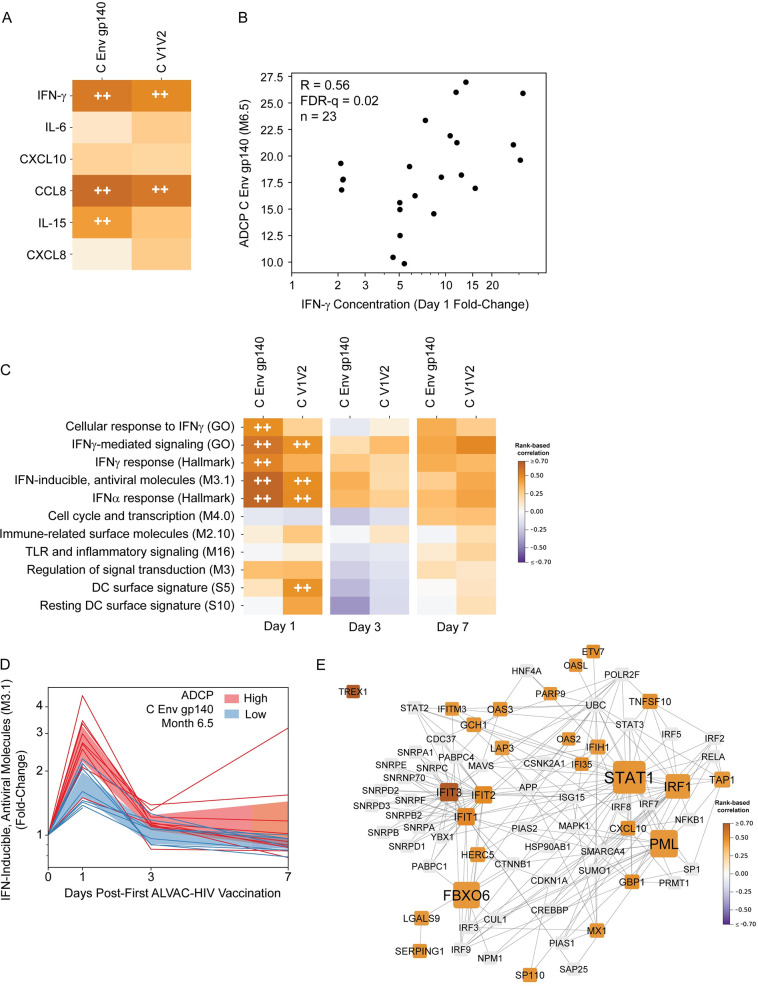
Strong associations between Day 1 changes in gene expression and Month 6.5 Env-specific antibody-dependent cellular phagocytosis (ADCP) responses.A) Heatmaps represent the strength of rank-based correlations of fold-change in serum cytokine concentrations with Month 6.5 ADCP responses. HIV-1 Env ADCP antigens are shown in columns. For detailed antigen names, see Materials and Methods. FDR-q <0.1 (++). B) Scatterplot of Day 1 fold-change of serum IFN-γ concentration vs. Month 6.5 ADCP C Env gp140 activity. Each dot represents a single participant response; R values in the upper left of the panel represent the strength of the rank-based correlations. C) Heatmaps represent the strength of rank-based correlations of fold-change in gene module scores with Month 6.5 ADCP responses. HIV-1 Env antigens are shown in columns. For detailed antigen names, see Materials and Methods. FDR-q <0.1 (++). D) “IFN-inducible, antiviral molecules (M3.1)” average module scores at Days 1, 3, and 7. Each line represents the module score for 1 participant. Individual trajectories are colored by Month 6.5 median-split ADCP C Env gp140 activity (blue = low and red = high); shaded region shows 95% CI of mean. E) Protein-protein interaction (PPI) network generated from DEGs whose Day 1 log2 fold-change showed a significant correlation with Month 6.5 C Env gp140 ADCP responses and that were also present in one of the five gene modules whose Day 1 log2 fold-change correlated significantly with Month 6.5 C Env gp140 ADCP responses. Edges represent protein-protein interactions. Nodes are sized according to degree; only nodes that had degree ≥3 in the original network generated from all the genes from the above modules are shown. Nodes are colored according to correlation of Day 1 log2 fold-change with C Env gp140 ADCP response magnitude at Month 6.5; only significant correlations are colored. Nodes with non-significant correlations are shown in gray.